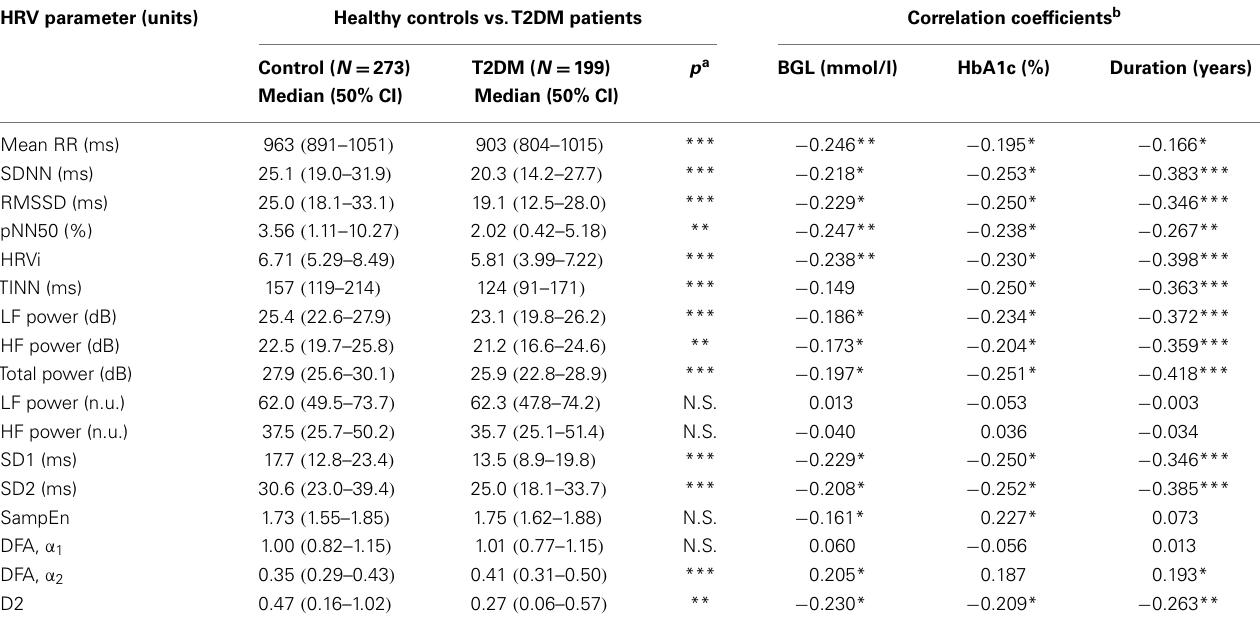
Table 2 | HRV parameter values for healthy control subjects andT2DM patients and their correlations with duration of diabetes, BGL, and HbA1c withinT2DM patients